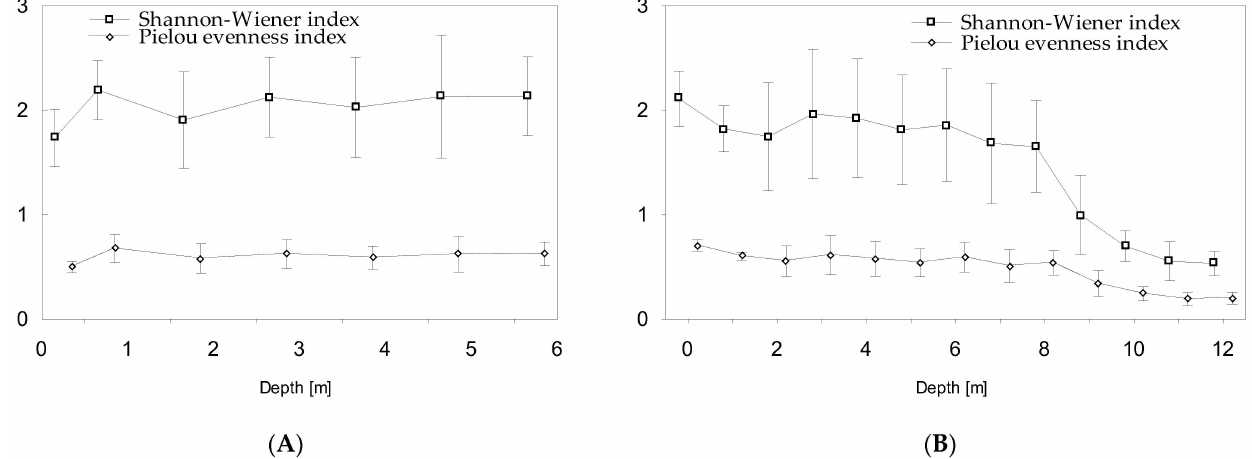
Figure 4. Mean values ( ± standard deviations) of Shannon–Wiener diversity index and Pielou evenness index in Lake Glinki ( A ) and Lake Piaseczno ( B